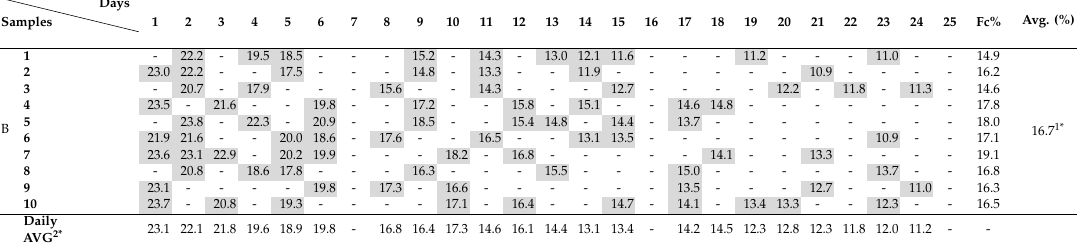
Table 12. Filler content measurement result (specimen